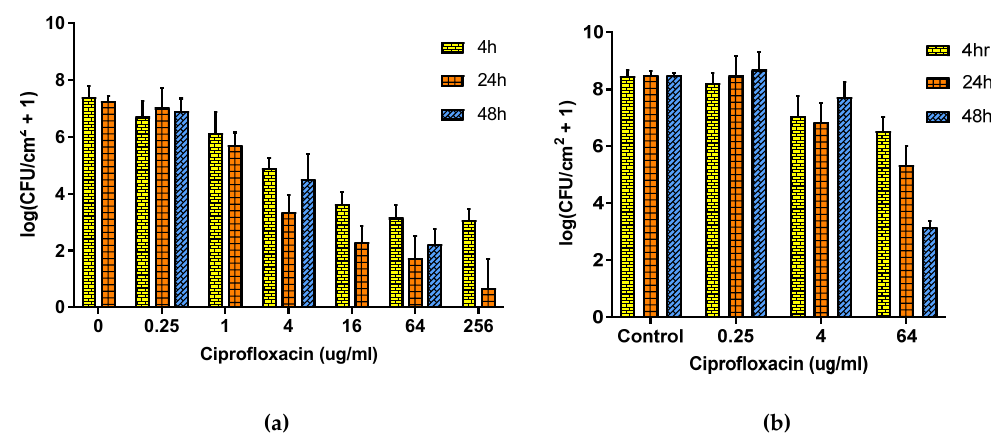
Figure 3. Effect of Ciprofloxacin on ST and DFR biofilms. ( a ) Effect of Ciprofloxacin on ST biofilm. ( b ) Effect of Ciprofloxacin on DFR biofilm. Error bars indicate standard deviation for at least six slides from three different dishes.